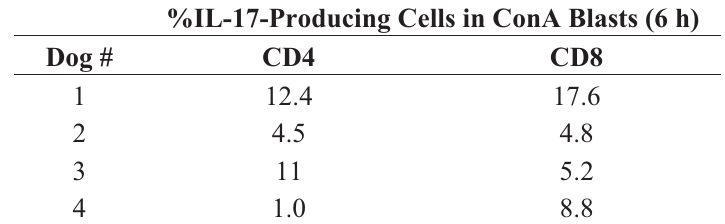
Table 1. Percentage of IL-17 + CD4 and CD8 cells after stimulation with ConA for 6 h a